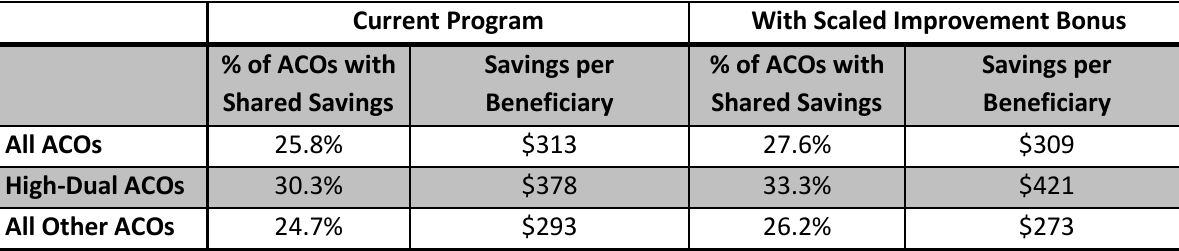
Table 9.15: Simulated Effects of Bonuses for High-Improving ACOs serving beneficiaries with social risk factors in the Medicare Shared Savings